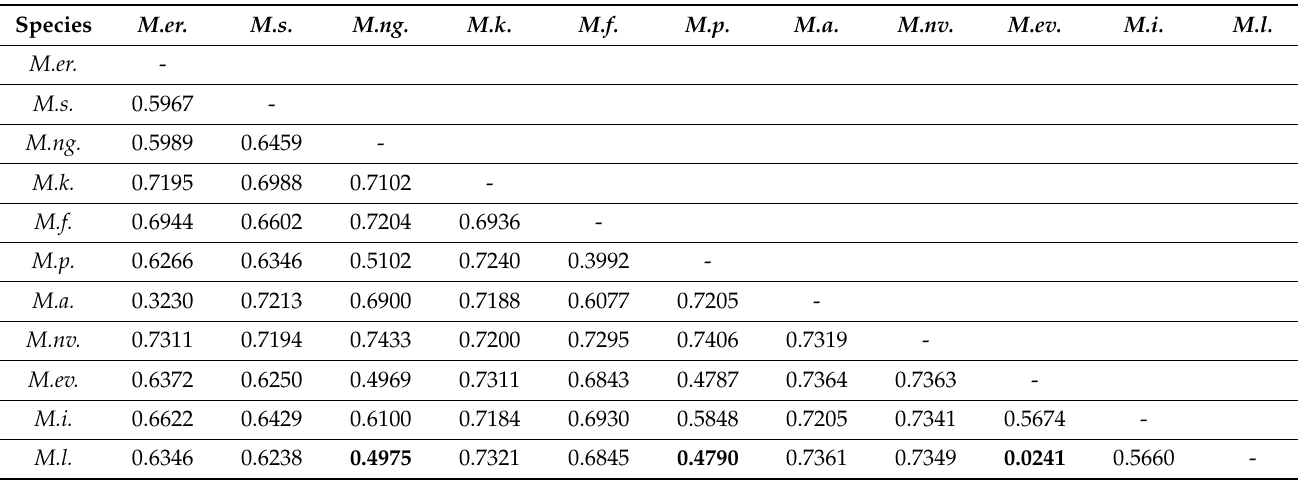
Table 6. Pairwise genetic distance 1 matrix of mitogenome sequences among specimens of the Mustela genus 2 (the number of base differences per site from between sequences are shown; all ambiguous positions were removed for each sequence pair).